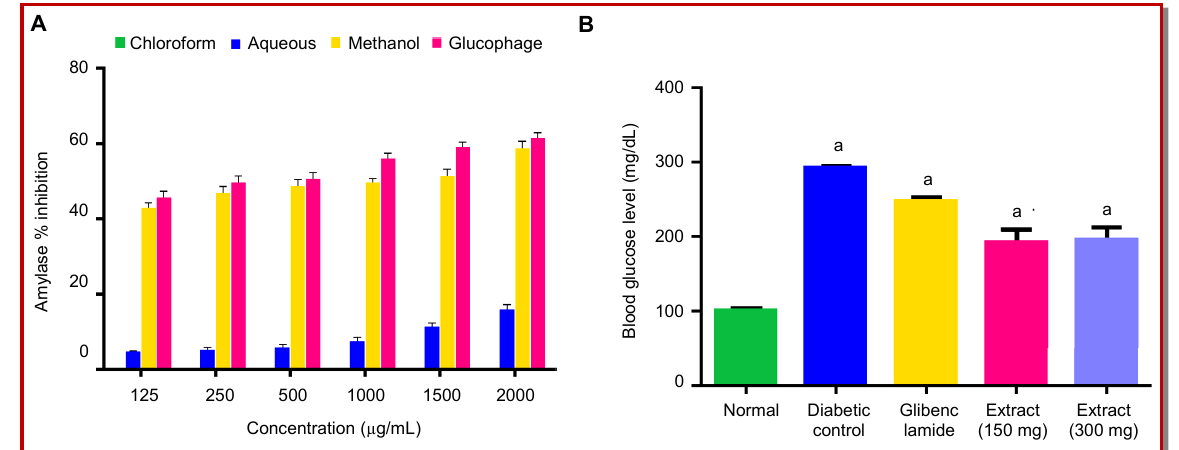
Figure 2: Anti-diabetic activity of I. aucheri leaves methanolic extract and its fractions as represented by %amylase inhibition (A). Chloroform extract had no effect; Effect of I. aucheri extract on blood glucose levels of diabetic rat (B). Data is represented as mean ± SD; a Significance at p<0.05 (Dunnett’s test); Normal was compared with the diabetic control, diabetic control were compared with the standard and extract-treated